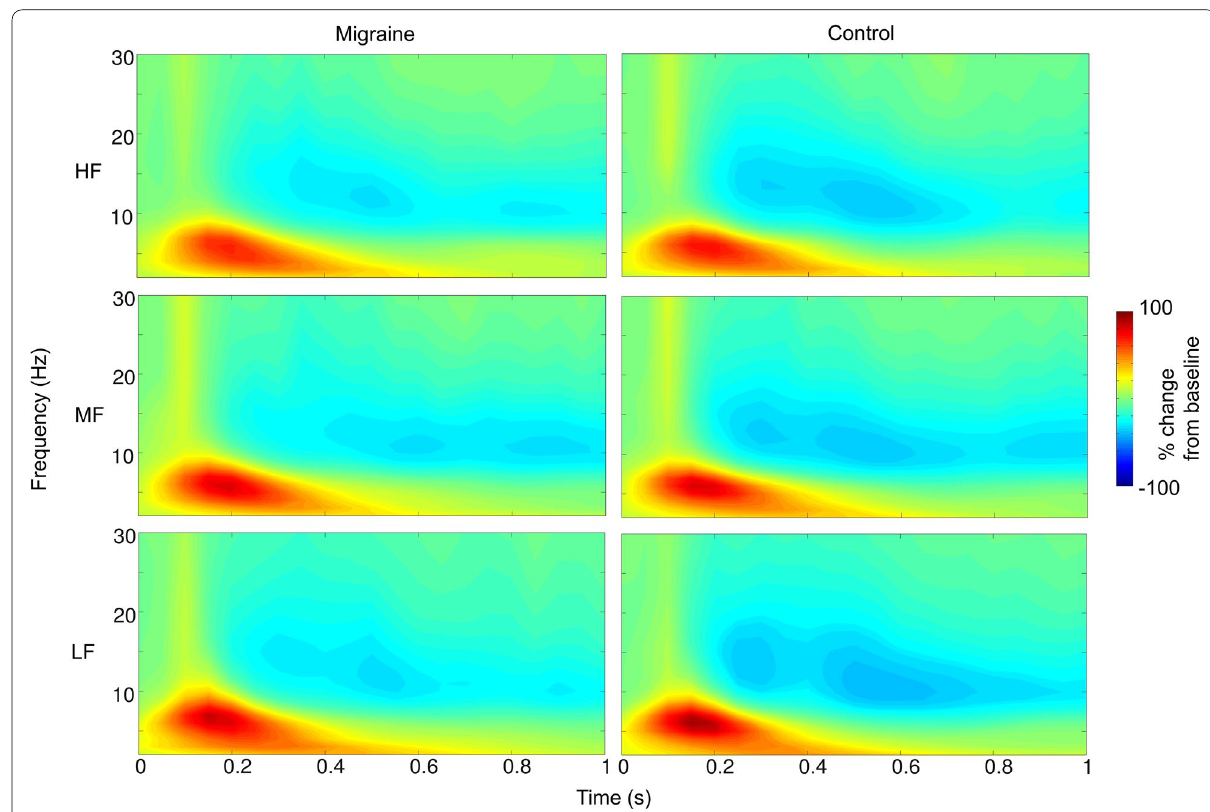
Fig. 7 The post-stimulus percentage change of power (migraine vs. control) across the three experiment conditions (HF, MF and LF). The spectrogram indicated the percentage change of power using the pre-stimulus interval